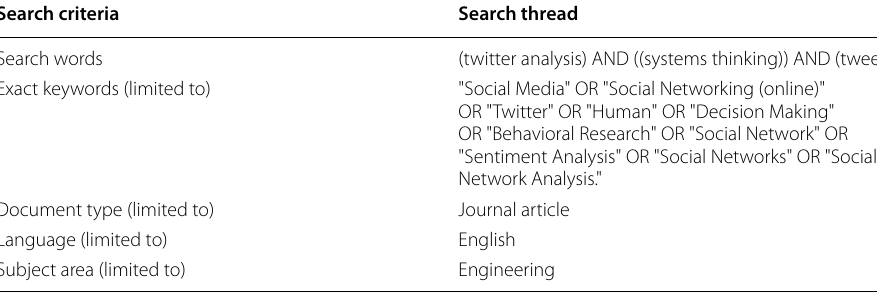
Table 4 The search thread for systematic literature search Search